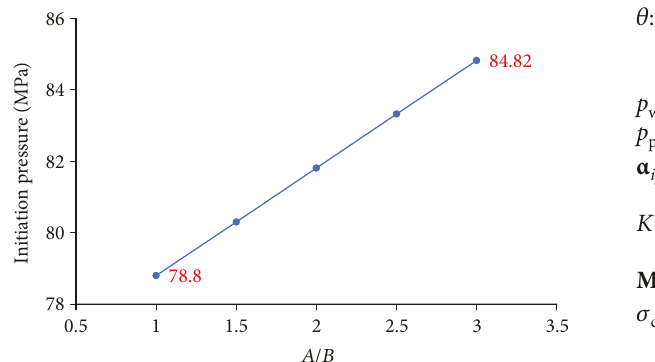
Figure 15: The relationship curve between initiation pressure and A / B